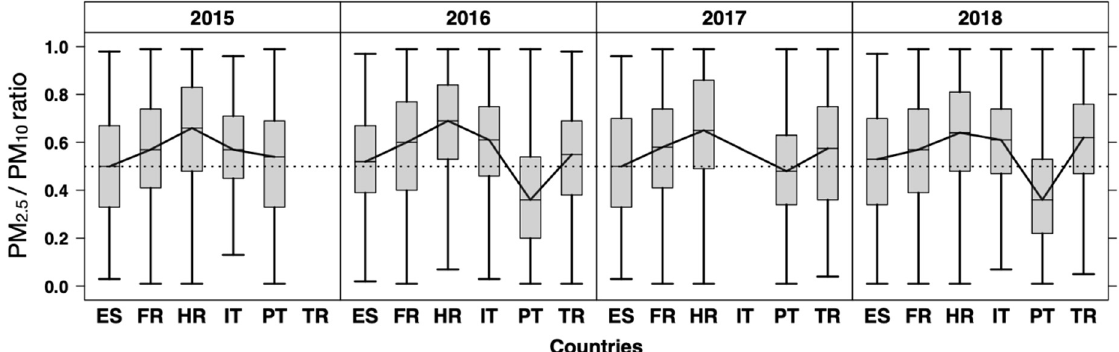
Figure 2. Distribution of the general evolution of PM 2.5 /PM 10 ratios in studied countries as box-whisker plots (2015–2018). As a reference, medians between countries are joined, and a dotted horizontal line is added at 0.5 ratio.